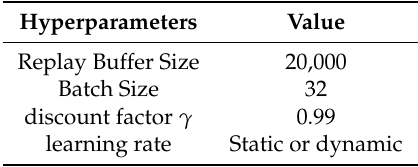
Table 1. Hyperparameters settings in the